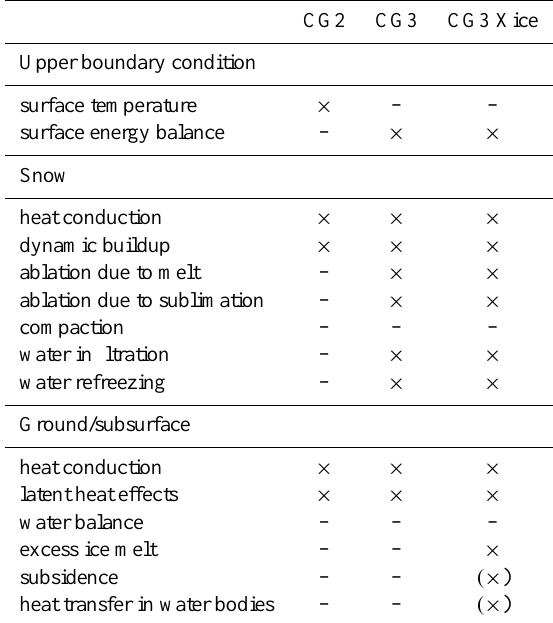
Table 1. Overview of the different processes that are accounted for in the models CryoGrid (abbreviated CG) 2 (see Westermann et al., 2013) and 3, as well as in the excess ice scheme Xice. Simplified parameterizations in brackets. CG2 CG3 CG3 Xice Upper boundary